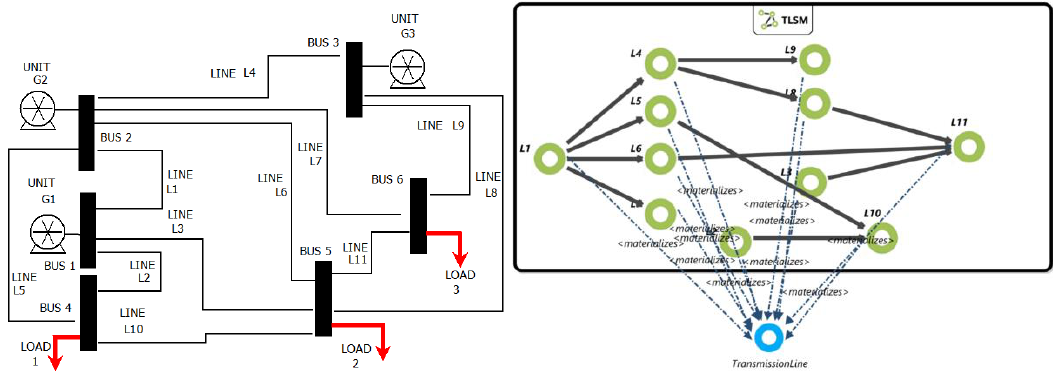
Figure 1. The 6 buses system one-line diagram. Figure 2. Routing situation of Figure 1 modeled with the RDEVS tool (Blas & Gonnet,